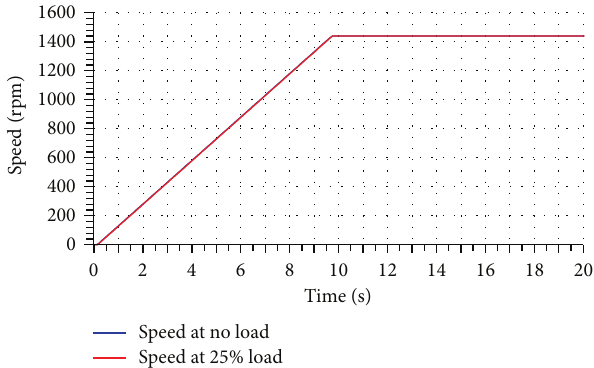
Figure 11: Speed variation of IM drive during starting at different loads and 1440rpm speed.